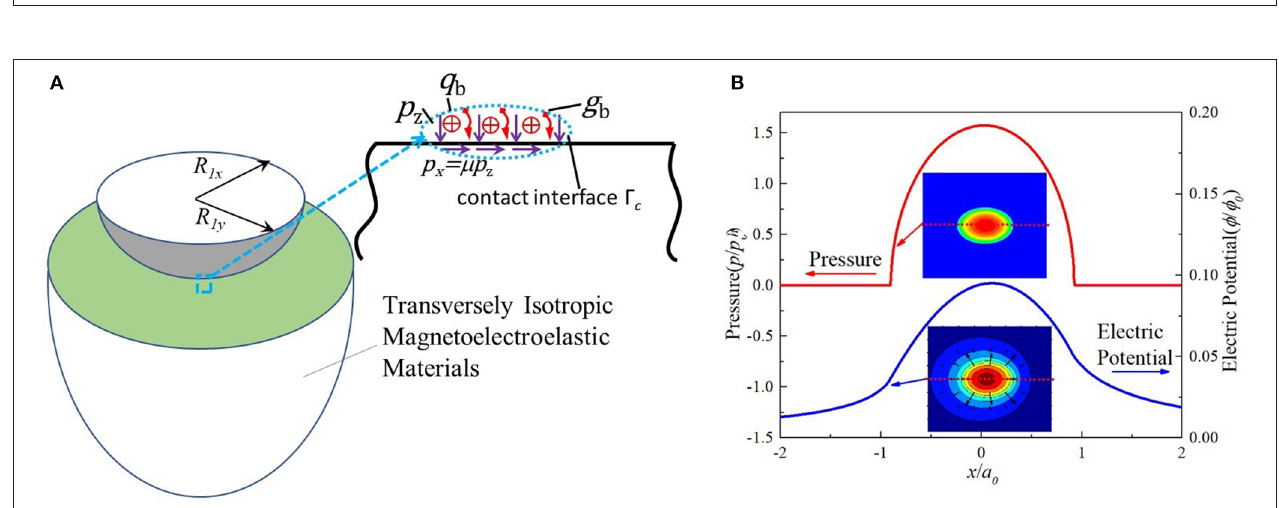
FIGURE 8 | Contact of magnetoelectroelastic materials subjected to interfacial contact pressure, p z , friction, p x , surface electric and magnetic charges, q b and g b , (A) ; solutions of pressure and electrical potential on the surface (B) .